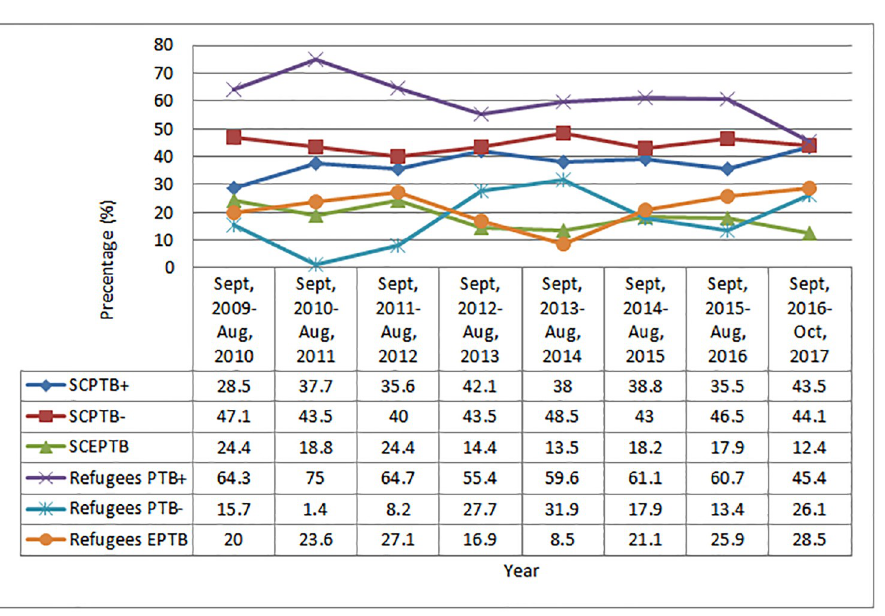
Fig 2. Trend of all types of registered TB cases (n = 4144) among refugees and surrounding communities in Gambella Regional State, South West Ethiopia, 2009–2017. Note: SCPTB+, Surrounding Communities smear positive pulmonary TB; SCPTB-, Surrounding communities smear negative pulmonary TB; SCEPTB, Surrounding communities extra pulmonary tuberculosis; Sept, September; Aug, August. There is significant difference in the trend of all form of TB in the two study populations (X 2 trend = 207.720; P <